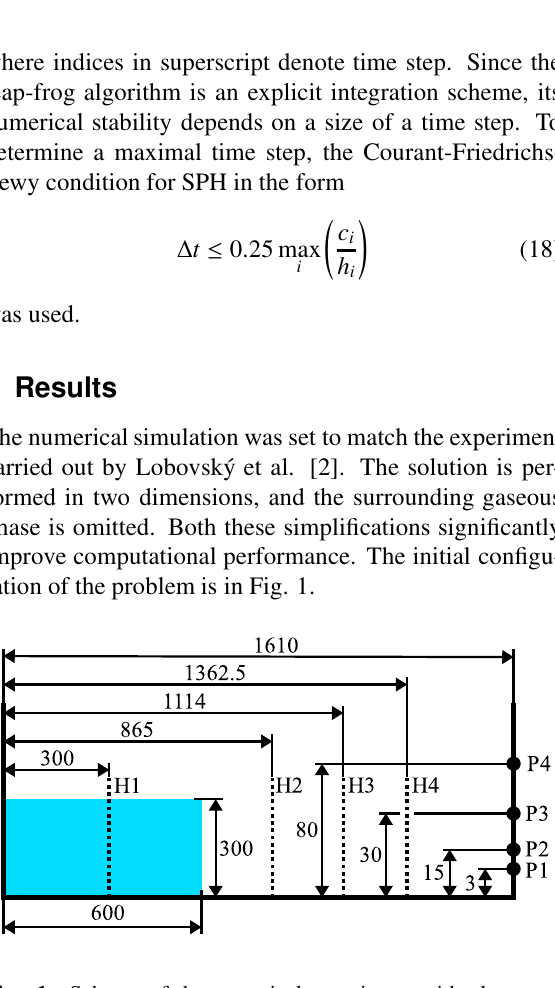
Fig. 1. Scheme of the numerical experiment with placement of the pressure probes and the positions of the surface height measurement. Dimensions in millimetres.